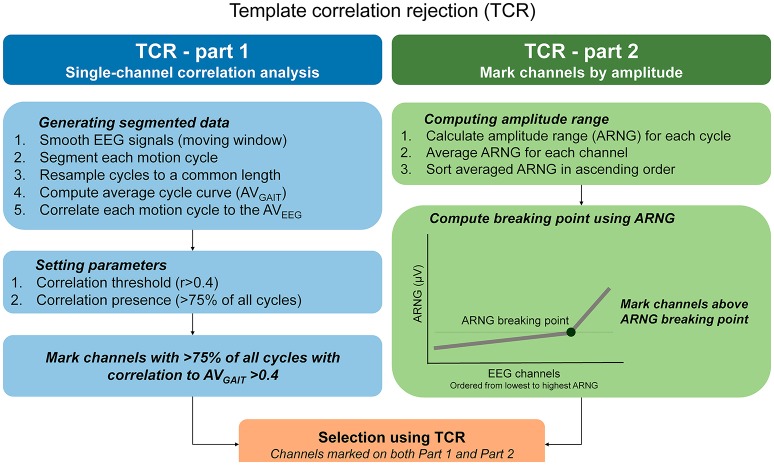
Step-by-step calculation of the template correlation rejection (TCR) method. In order to underpin EEG channels carrying motion-related artifacts, the TCR method quantifies the amount of EEG epochs minimally correlated to a channel template, and defines among these channels those exhibiting amplitude ranges (ARNG) unexpectedly higher in comparison to the pool of EEG channels (C).